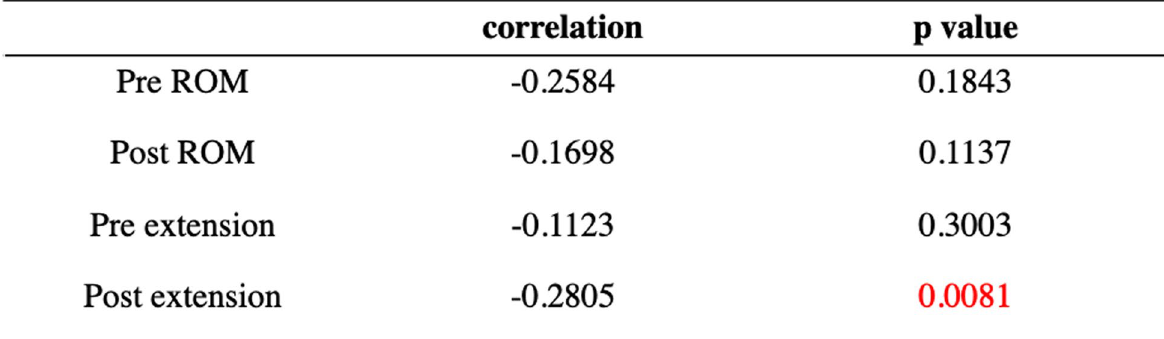
Table 5 Correlation between changes of pelvic inclination and knee motion